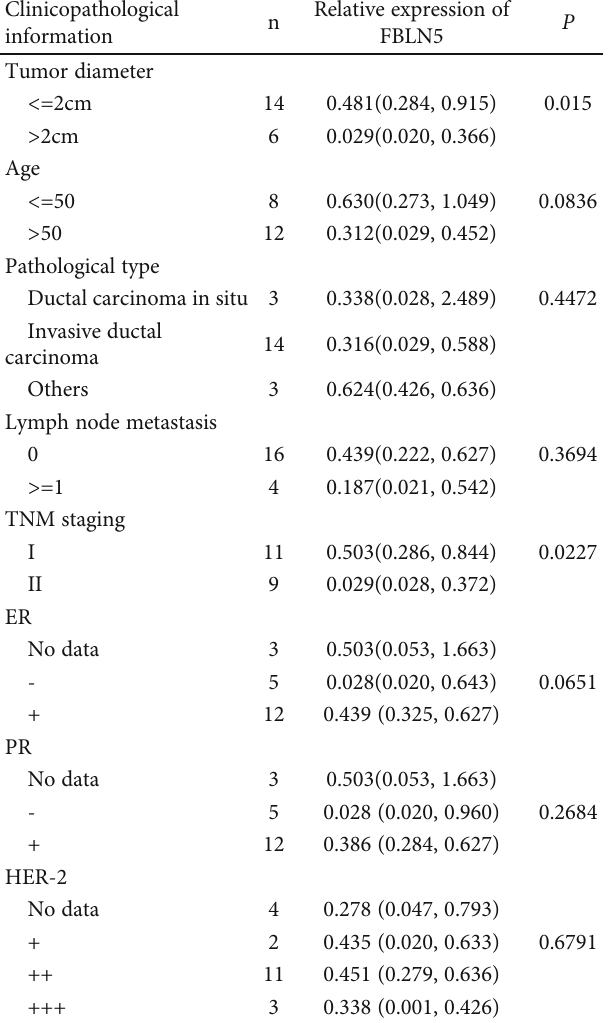
Table 1: Correlation between FBLN5 in breast cancer tissues and clinicopathological